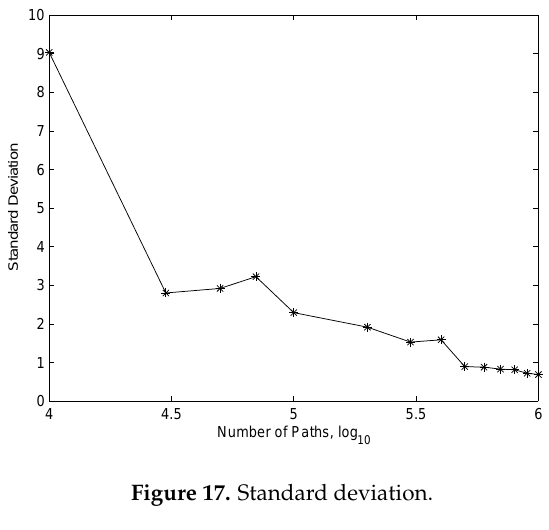
Figure 17. Standard deviation.